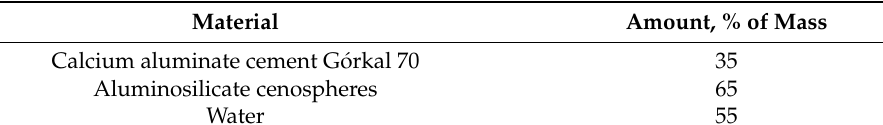
Figure 2. XRD difractogram of the aluminosilicate cenospheres (M-mullite). Table 1. The proportion of materials in the ALRC. Material